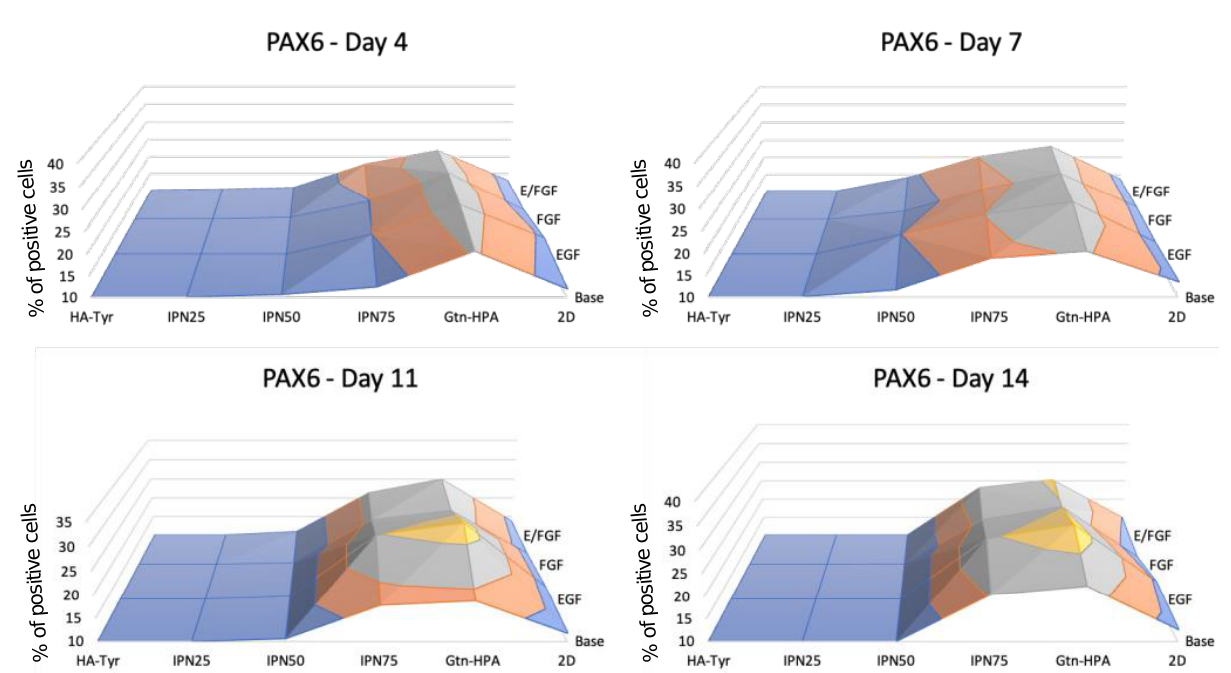
Figure 6. Phenotype assay for retinal marker PAX6 of hRPCs in different tissue culture. Cells were cultured for 2 weeks and phenotype was analyzed at day 4, 7, 11, and 14 for n = 5 replicates with flow cytometry. Map surfaces show the medium component on the x -axis (base medium, EGF, FGF, or both), the tissue culture on the y -axis (2D, Gtn-HPA, IPN75, IPN50, IPN25, and HA-Tyr) and the expression of PAX6 is shown on the z -axis.